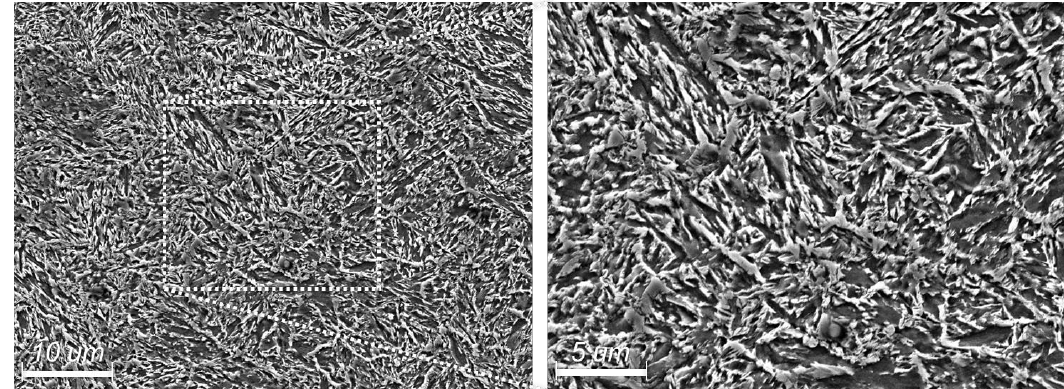
Figure 14. SEM micrographs of the microstructures of the HTCS-150 deposited on